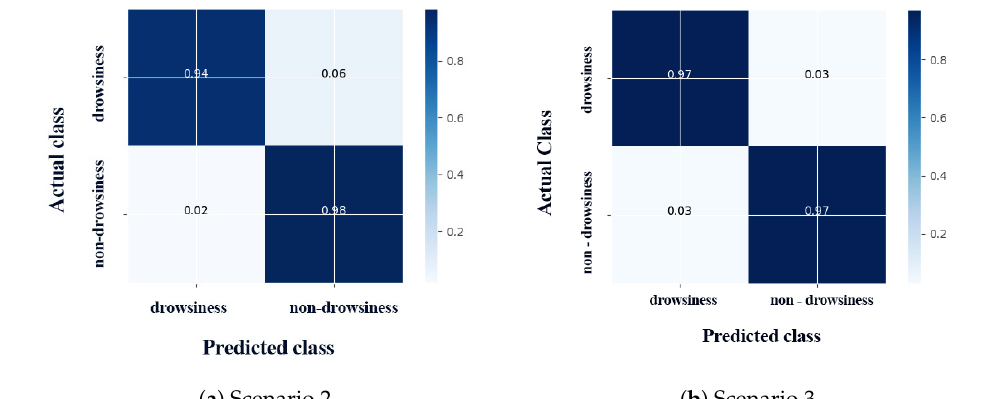
Figure 13. Confusion matrix for scenarios 2 and